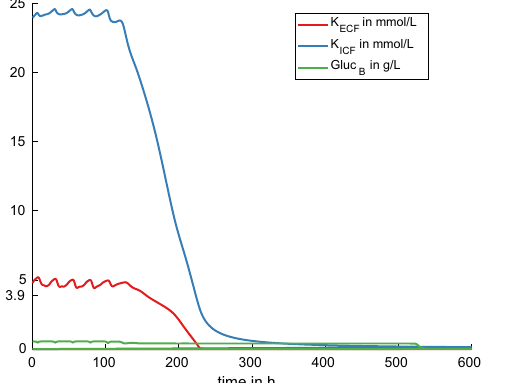
(b) The model component DMI is slowly faded out until reaching 0 at time t = 130h. K TISS decreases towards its lower bound, and the increase in K URIN (accumulated) is reduced but ongoing.